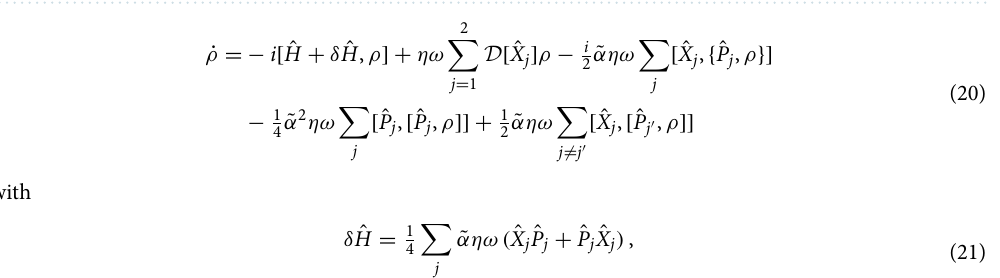
Figure 5. Correlations in the dissipative KTM model. ( a ): Discord D against time (in units of ω − each mass starts in a coherent state and for some representative values of parameter fact by definition 10 ). The case discord (purple line) and mutual information (yellow) versus calculated using Eq.